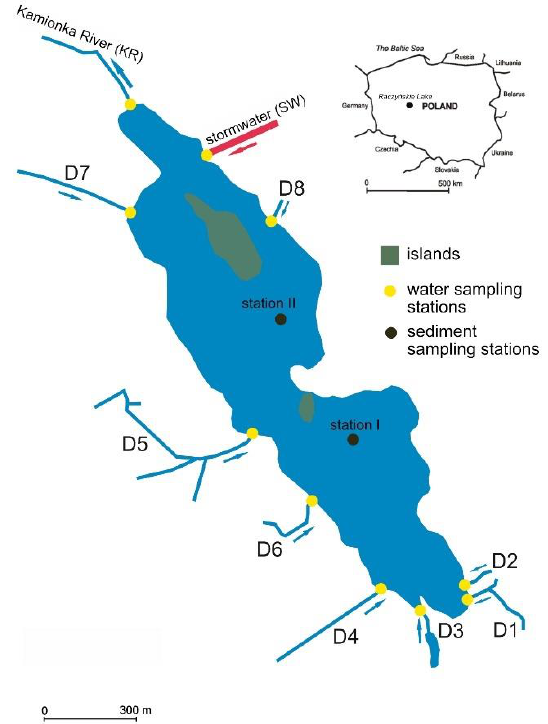
Figure 1. Location of sampling stations at the tributaries of Raczyńskie Lake (D1– D8), stormwater inflow (SW), outflowing Kamionka River (KR) and at Raczyńskie Lake (I and II).